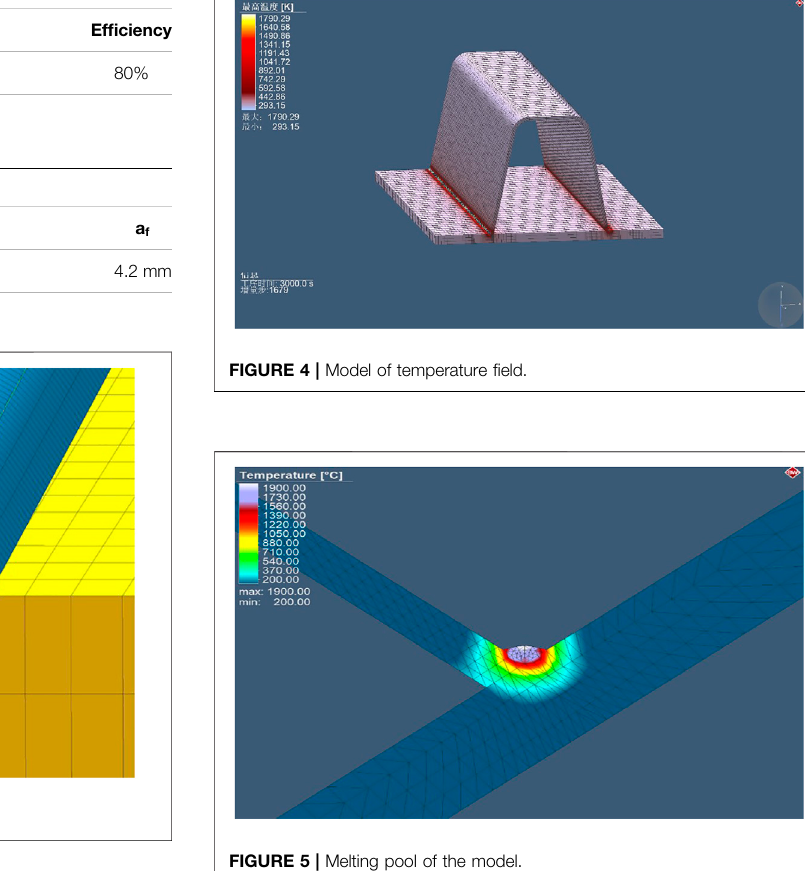
FIGURE 5 | Melting pool of the